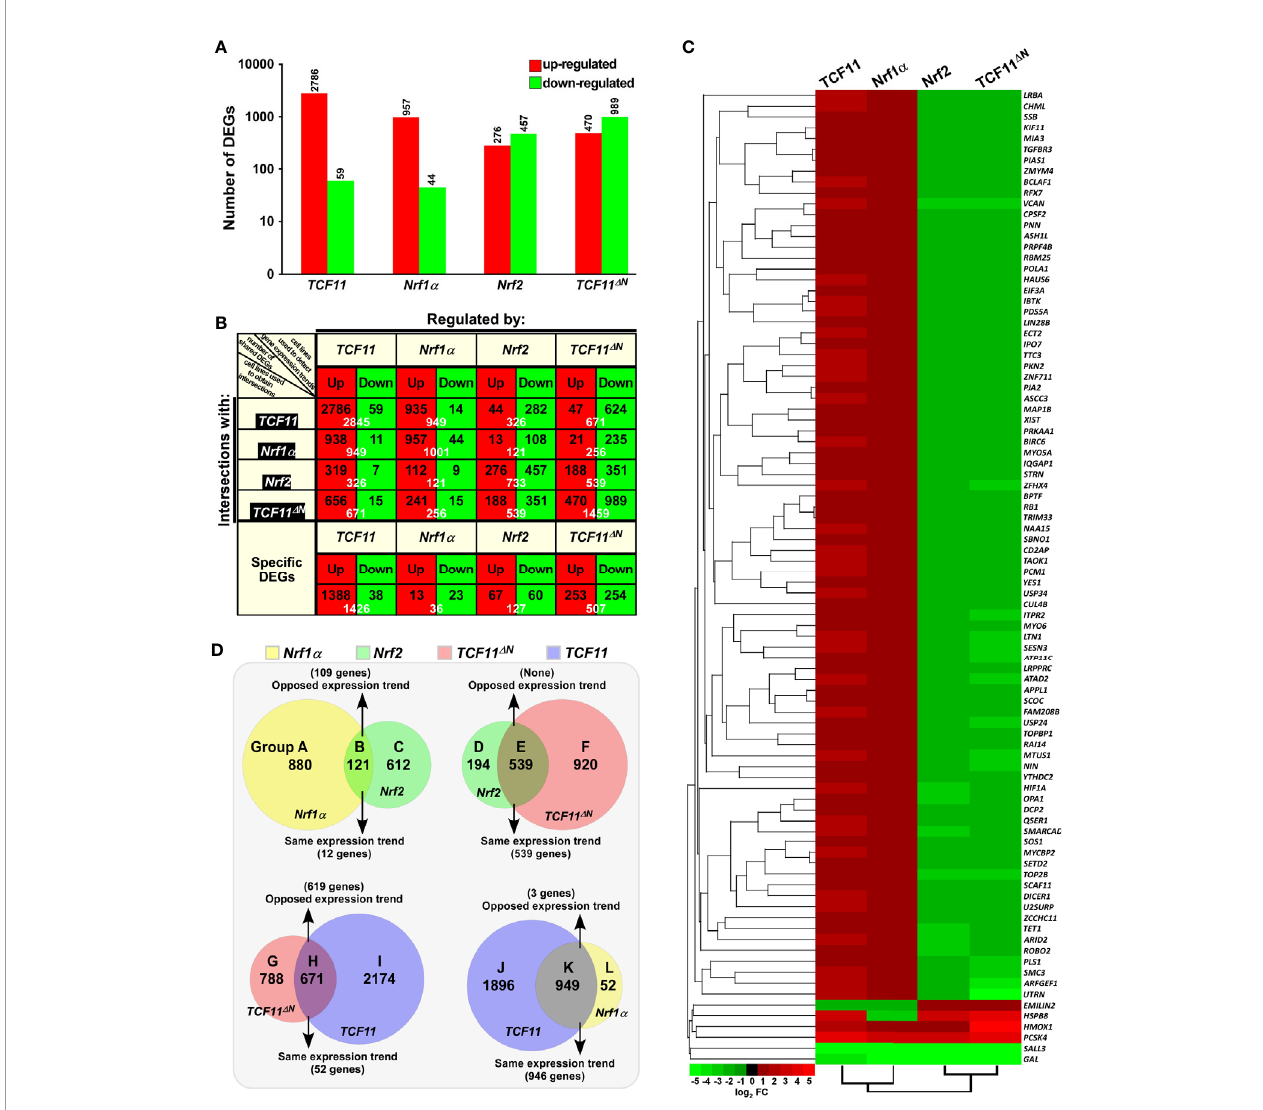
FIGURE 2 | Statistical analysis of the data obtained from transcriptome sequencing. (A) Differentially expressed genes (DEGs) in distinct cell lines were analyzed by transcriptome sequencing, and relevant differences in the number of those increased or decreased DEGs are shown in the histogram. The DEGs were selected according to the following criteria: fold change ≥ 2 or ≤ 0.5 and FDR ≤ 0.001 (as compared to the Control cells). (B) The speci fi c DEGs in each cell line and their common DEGs between every two cell lines were also counted as indicated in the chart, and the number of increased and decreased DEGs in each group is shown separately in black font, and the total is shown in white. In addition, the change trends of DEGs in each group were indicated in red or green, which represent up- regulated or down-regulated in the cells in the fi rst row, respectively. (C) The heatmap with hierarchical clustering of 90 DEGs shared in all four cells lines. (D) Distinct groupings of the subsequent functional annotation and also the Venn diagram of DEGs between every two cell